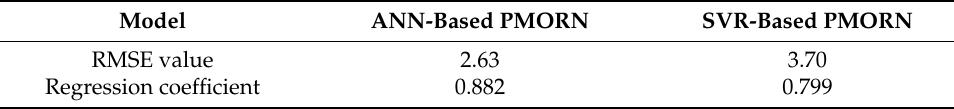
Table 2. RMSE and regression coefficient of the two